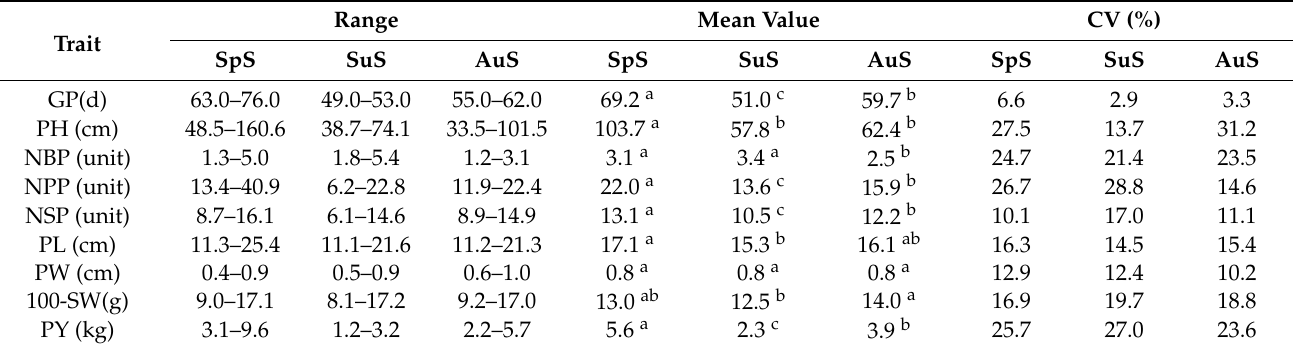
Table 2. Mean values, ranges, and coefficients of variation among sowing